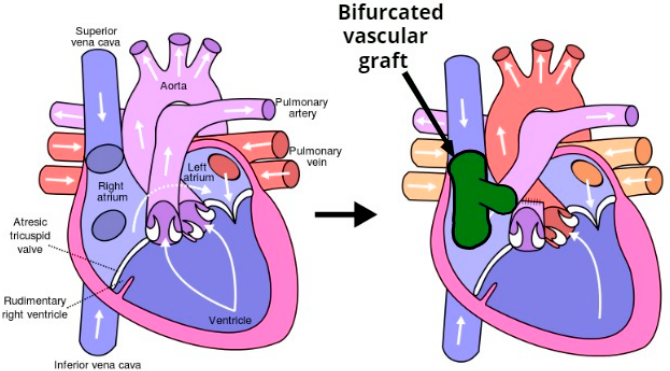
Figure 1. The Fontan procedure reconnects the inferior vena cava and superior vena cava to the pulmonary arteries avoiding the right ventricle.